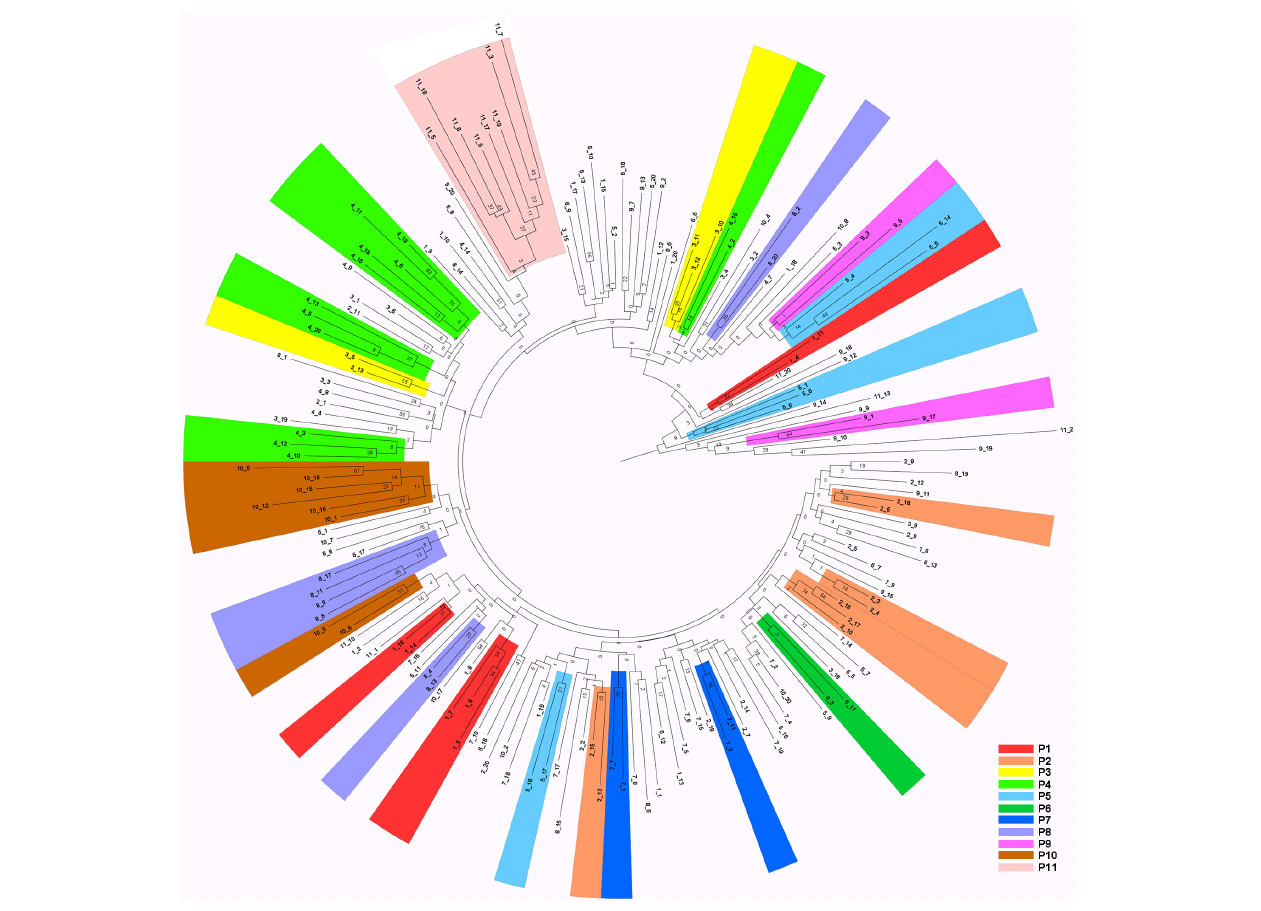
FIGURE 4 | Neighbor-joining tree derived from the concatenated sequences. Clustered two or more individuals from the same location are painted . Nodes are named using the sample number. Bootstrap values are shown on the nodes .